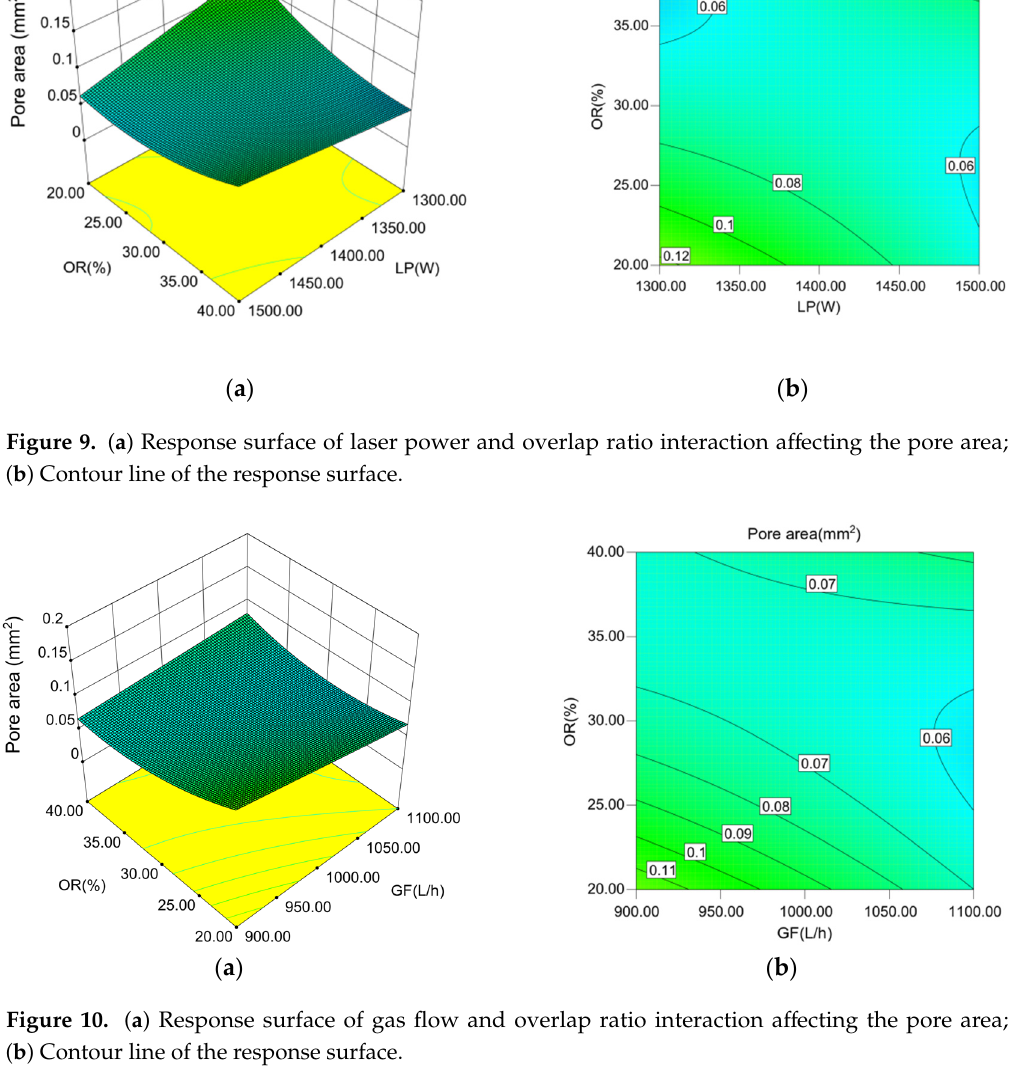
Figure 11. The influence of different processing parameters on the pore area.